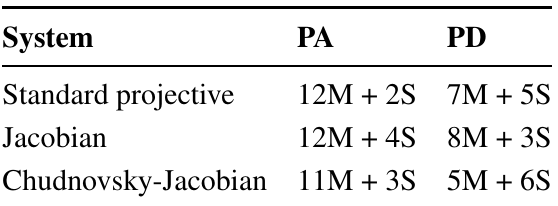
Table 1. Performance of coordinate systems in prime fields. PA, point addition; PD, point doubling; M, multiplication; S, squaring.